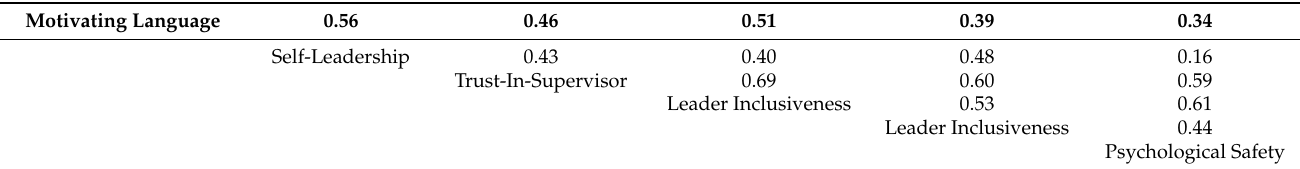
Table 4. Study Variable Correlations, Controlled for